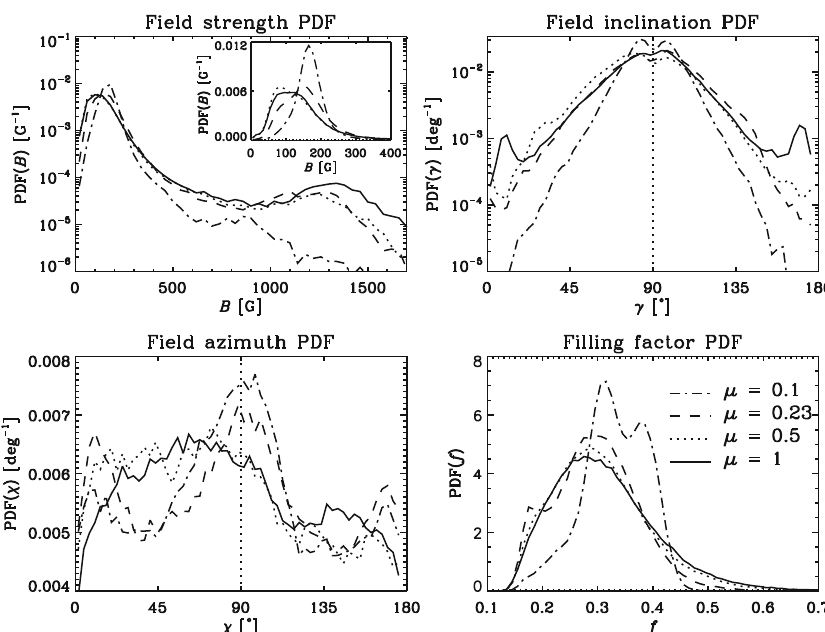
Fig.37 Magnetic field strength, inclination, azimuth, and filling factor distributions in the IN as calculated from ME inversions of high signal-to-noise ratio Hinode/SP measurements at different heliocentric angles. The inset in the field strength panel shows the weak-field end of the distribution in linear scale. Inclinations are measured with respect to the line of sight. Image reproduced with permission from Orozco Suárez and Katsukawa (2012), copyright by